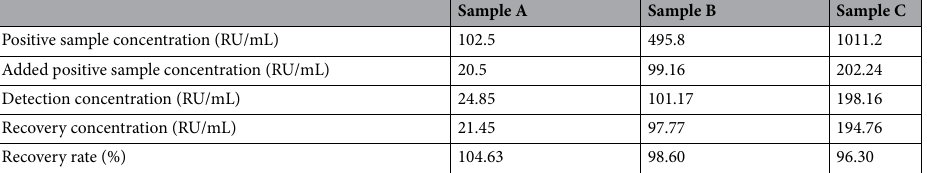
Table 4. Evaluation of the serum matrix effects. Positive sample concentration is defined as the concentration of samples that were positive for PLA2R antibodies, as detected by ELISA (EUROIMMUN). The detection